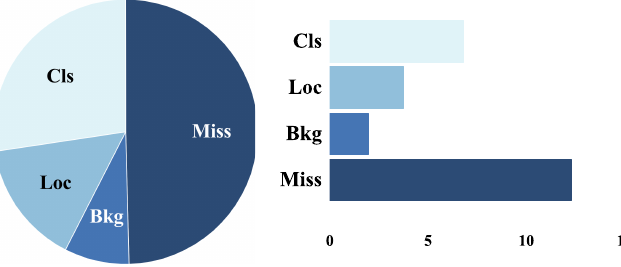
Figure 1. The main error sources in cross-domain object